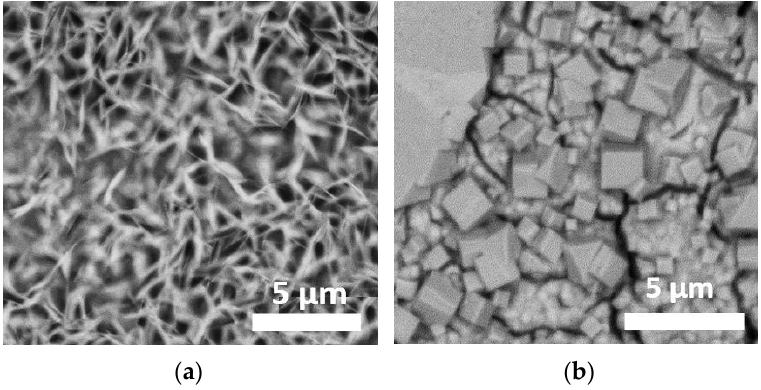
Figure 3. SEM images of the corroded MgZr substrates at 360 days in ( a ) PS and ( b ) NaF-PS.